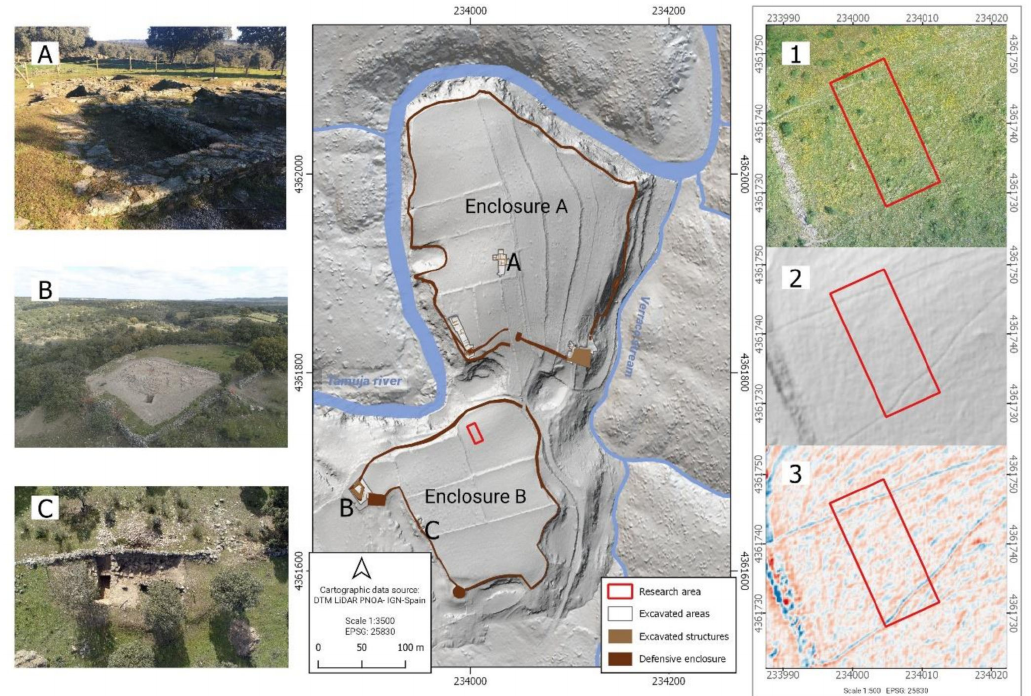
Figure 2. LiDAR digital terrain model (DTM) image of the study area. Photographs ( A – C ) show excavated areas, and the red rectangle in enclosure B corresponds to the zone analysed in this work. Images on the right show the research area in an orthophotograph ( 1 ), LiDAR DTM hillshade ( 2 ) and simple local relief model (SLRM) derived from the LiDAR DTM ( 3